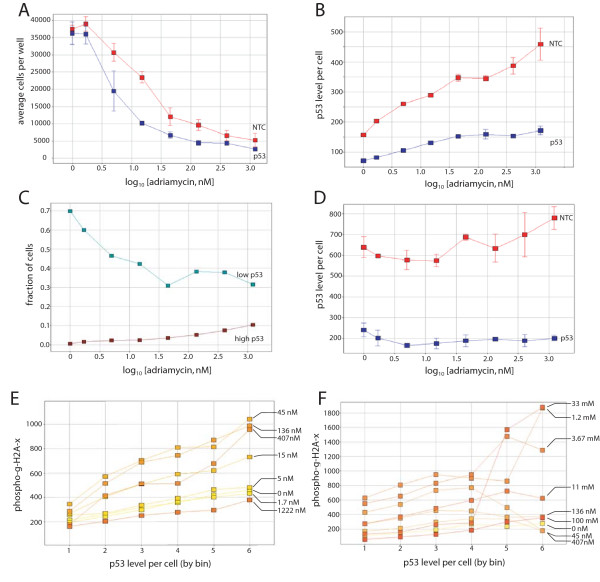
Dependence of p53 on the response to adriamycin is observed in both p53 siRNA treated cells and in untreated cells with low levels of p53. A. DLD-1 colon carcinoma cells treated with increasing doses of adriamycin as indicated in the figure. Cells were treated with an siRNA targeting GFP (blue) or an NTC (red). Cells not treated with adriamycin were treated with DMSO. B. p53 levels following siRNA treatment. An siRNA that targets p53 (blue) or a non-targeting control (red), are shown. siRNA treatments as described in A. C. The fraction of cells within each concentration of adriamycin for the NTC treated sample is shown. The fractions of cells with the highest and lowest 20% of the range of p53 levels (burgundy and teal, respectively) in the untreated sample are shown at each concentration of adriamycin. The range of p53 levels in each bin is 0–200 FU for the lowest bin and 800–1000 FU for the highest bin. D. p53 levels following p53 or NTC siRNA treatment for 48 hours, and adriamycin treatment for 6 hours. siRNA treatments as described in A E. Levels of γ-phosphorylated histone H2A-x levels as a function of p53 levels per cell and adriamycin treatment for 6 hours. Adriamycin doses are as shown in other panels, in a color range from yellow (no adriamycin) to orange (1.222 μM adriamycin). Each data point represents 200–400 cells. F. Same as (E), except cells were not treated with an NTC siRNA. Adriamycin concentrations are indicated in the panel.